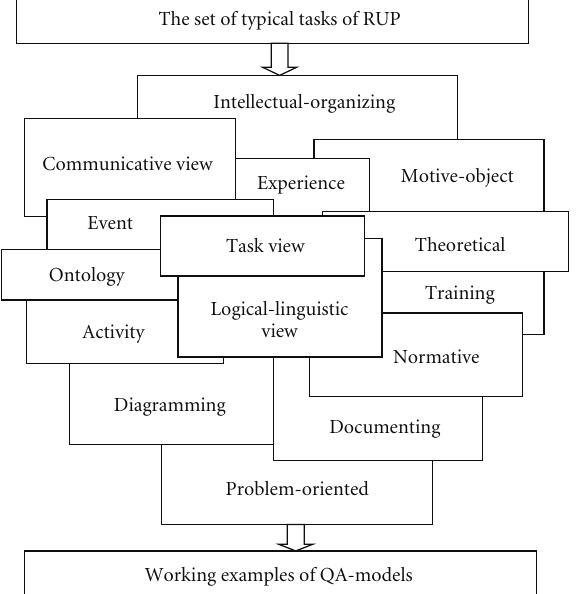
Figure 3: Architectural description of QA-model.